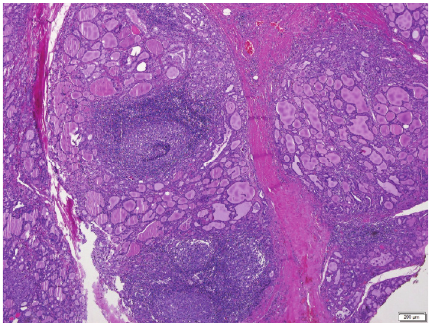
Figure 6: Lymphocytic thyroiditis (H&E,